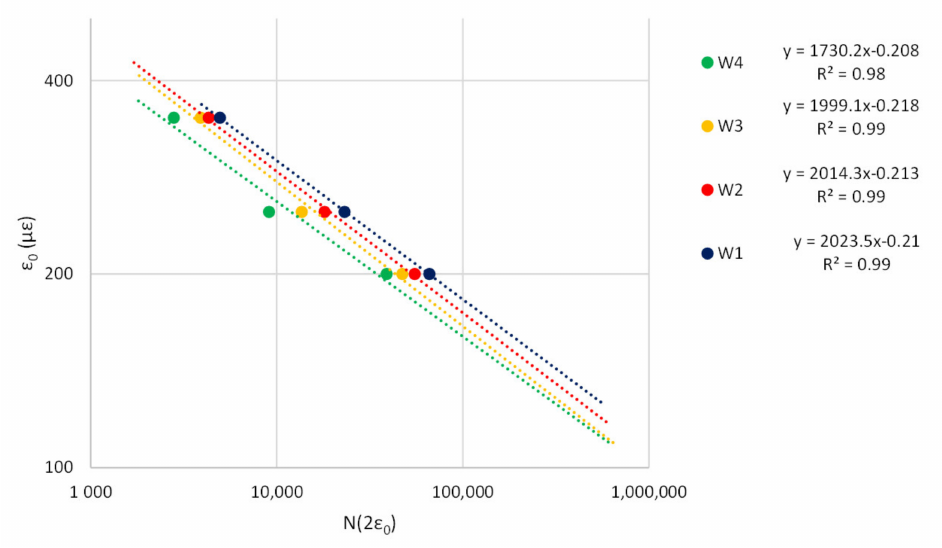
Figure 14. Fatigue curves—wearing mixtures.